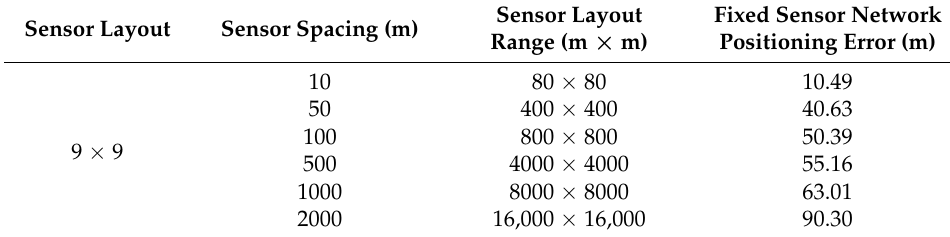
Table 2. Average positioning error of different sensor intervals with the same layout.